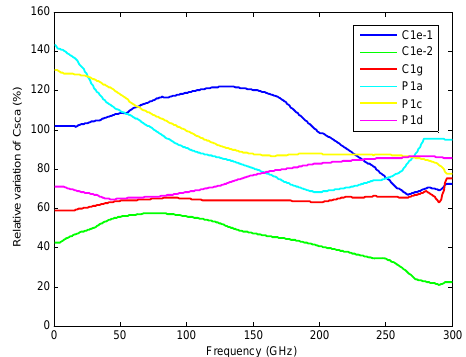
Fig. 6. Maximum relative variation of Csca of ice crystals compared to an equal volume sphere.